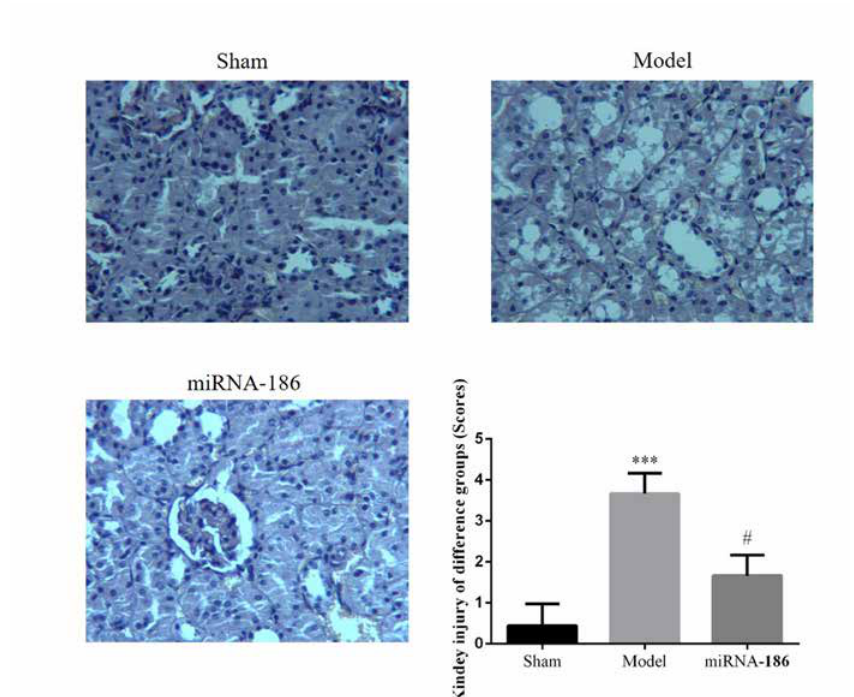
Figure 1: Pathological observation of difference groups, ***: P0.05, compared with Sham group, #: P < 0.05, compared with Model group